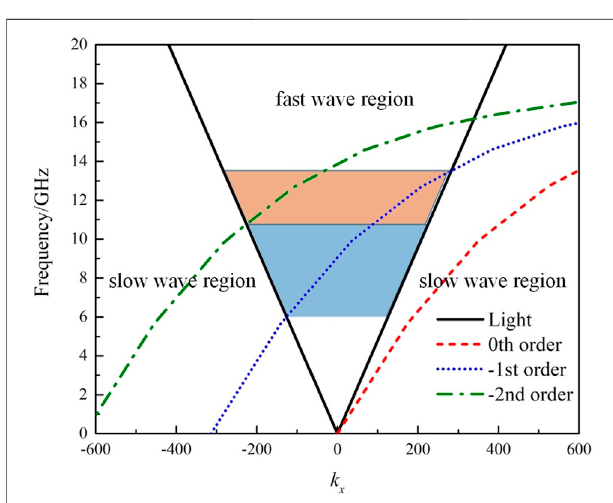
FIGURE 4 | The dispersion relationship of space harmonics.